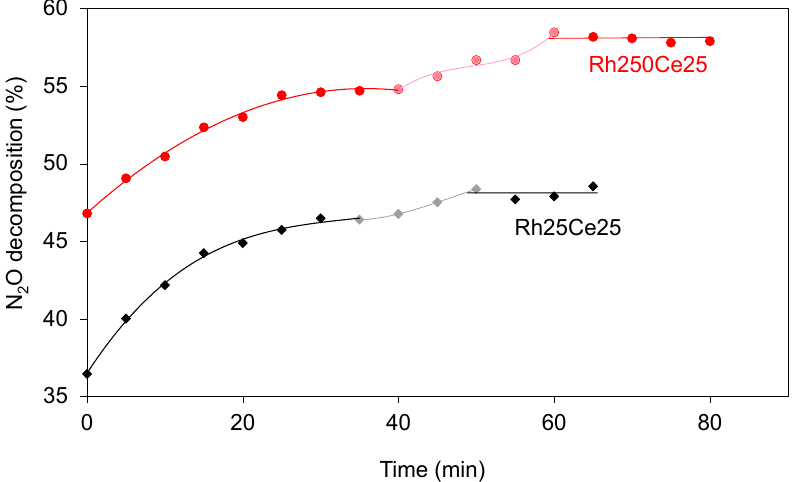
Figure 5. N 2 O decomposition at 225 °C as a function of